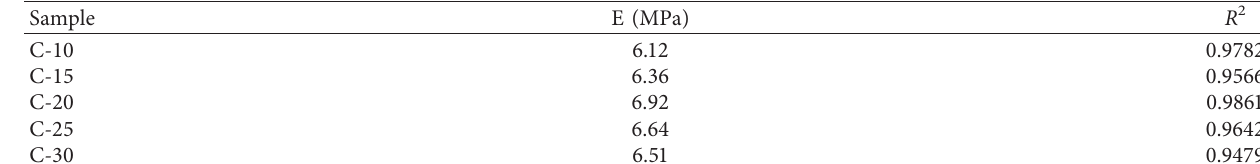
Table 2: Calculated Young’s modulus data for coating